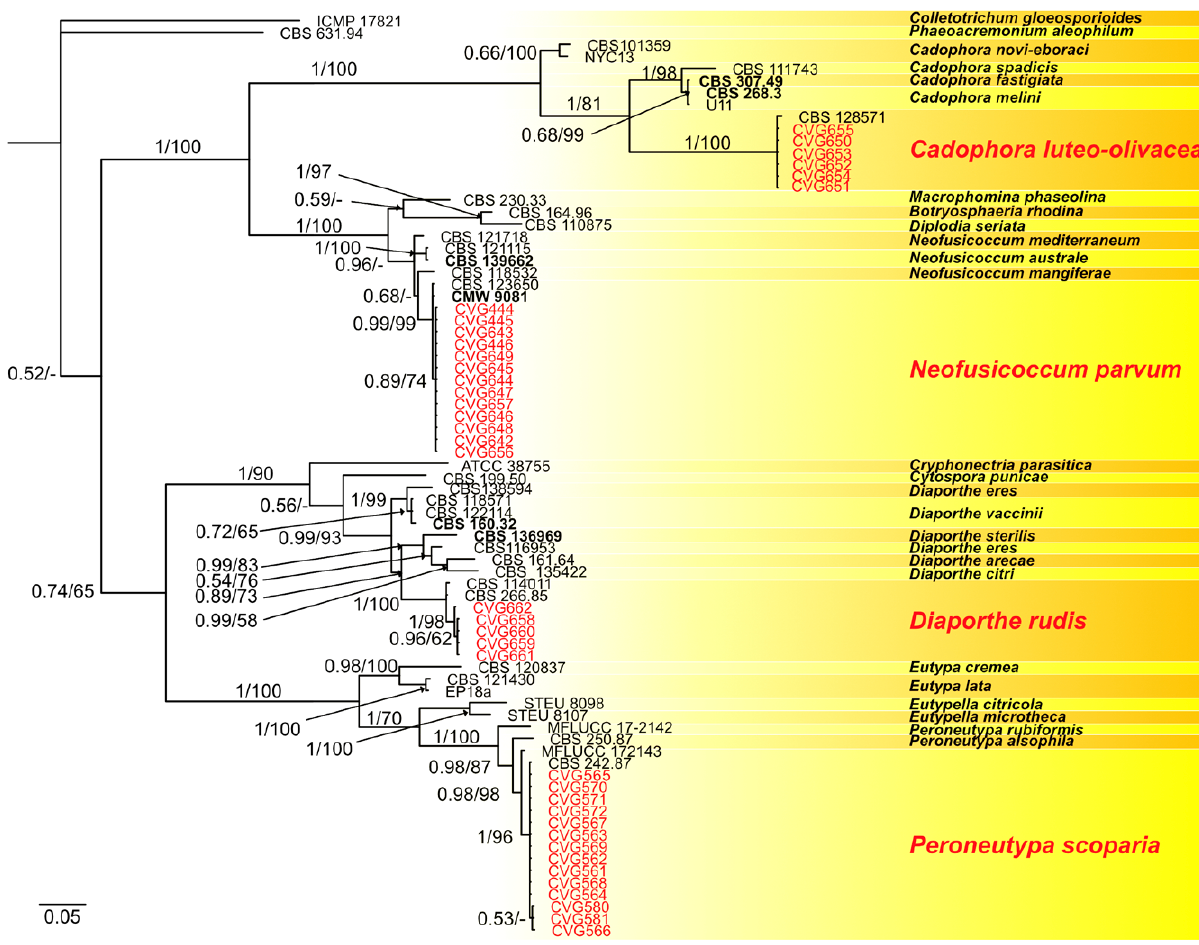
Figure 2. Consensus phylogram of 1,542 trees resulting from a Bayesian analysis of the ITS sequences of 38 fungus isolates collected in this study (in red) and further reference strains. Bayesian posterior probability values and bootstrap support values are indicated at the nodes. The tree was rooted to Colletotrichum gloeosporioides (ICMP